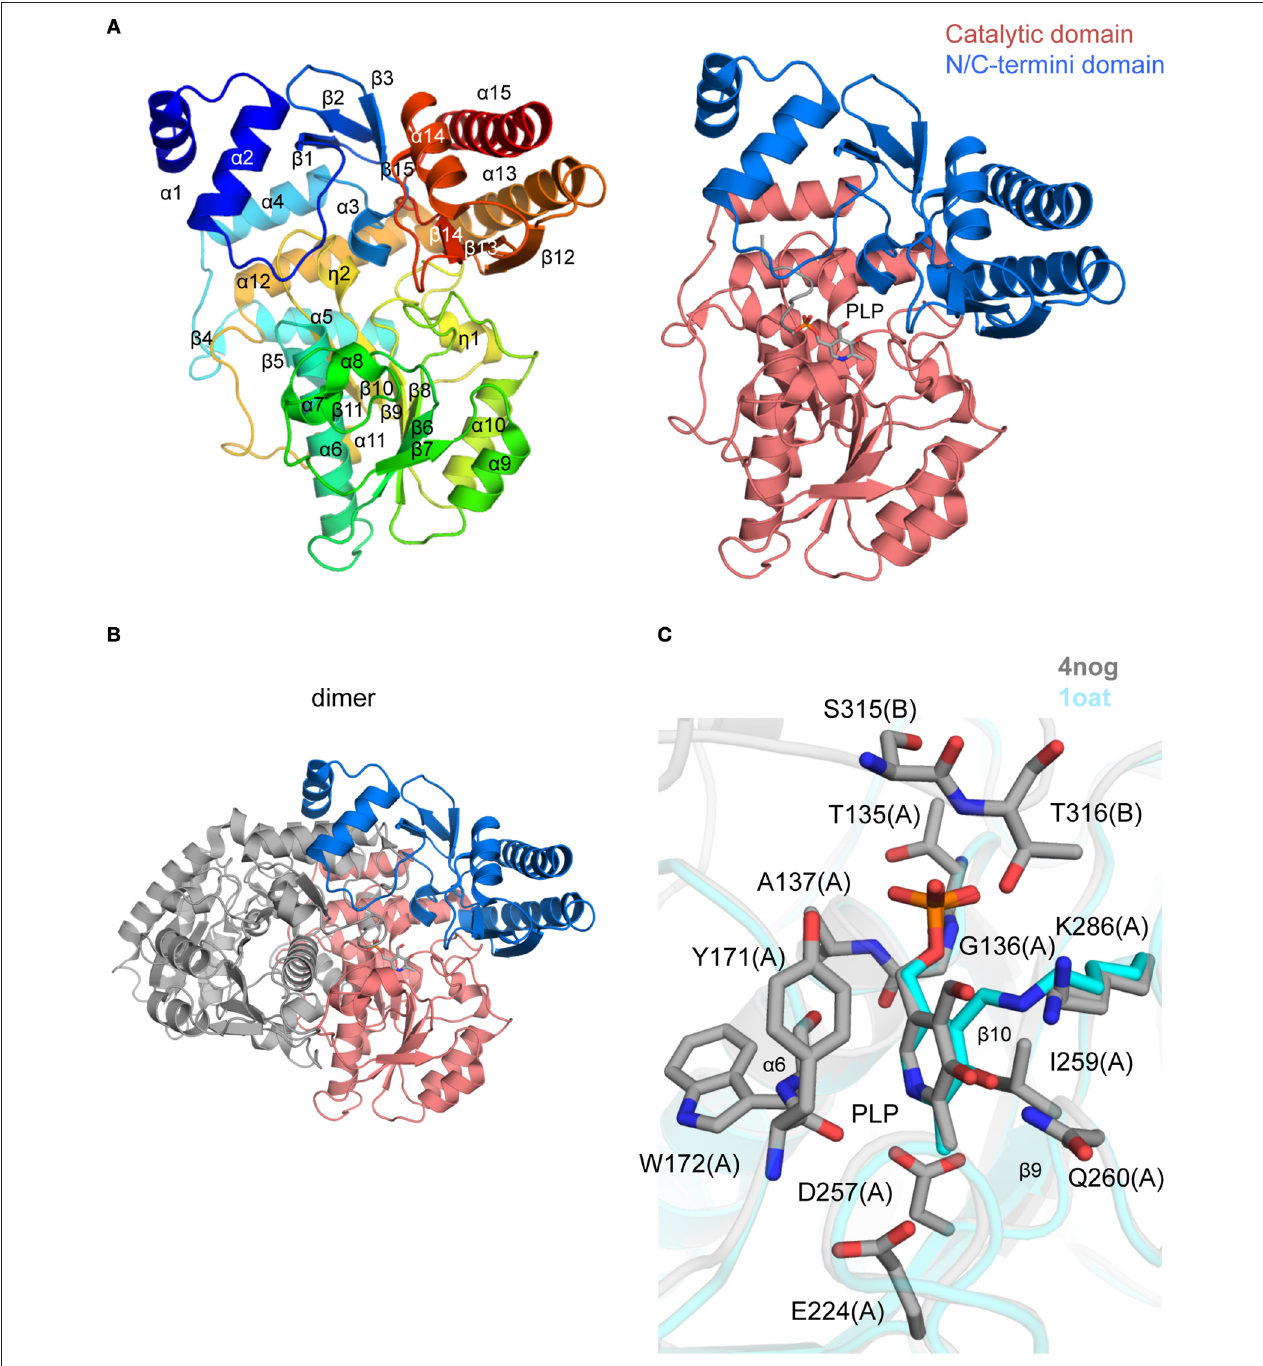
FIGURE 6 | Crystal structure of Tg OAT (A) . Ribbon representation of Tg OAT monomer (left side) colored blue (N-terminus) to red (C-terminus). Catalytic and N/C-termini domains with bound PLP are shown on the right (B) . Dimer of Tg OAT (C) . Pairwise structural alignment of Tg OAT (gray; PLP is shown in sticks) and h OAT with bound PLP (cyan ribbon; PDB 1oat). Residues of Tg OAT are shown in sticks and labeled in one-letter code. Equivalent lysine residues of h OAT are displayed. Chain identifier in parentheses.